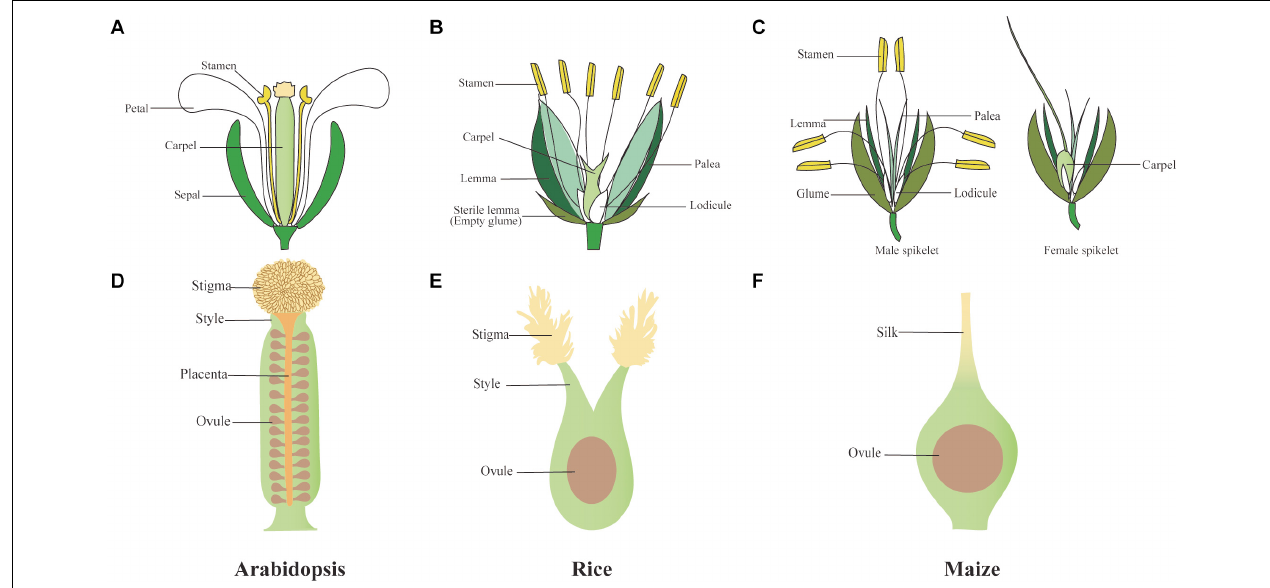
FIGURE 1 | Schematic draws of Arabidopsis , rice, and maize florets and gynoecia. (A–C) Flower and spikelet structure of Arabidopsis (A) , rice (B) , and maize (C) . (D) The pistil of Arabidopsis can be divided into ovary, style, stigma, and the ovules derive from a placenta (E) Rice syncarpic ovary harbors two styles and feathery stigmas, (F) while maize has a higher extent of fusion into one silk. Like in all grasses, only one ovule is developed in the pistil of rice and